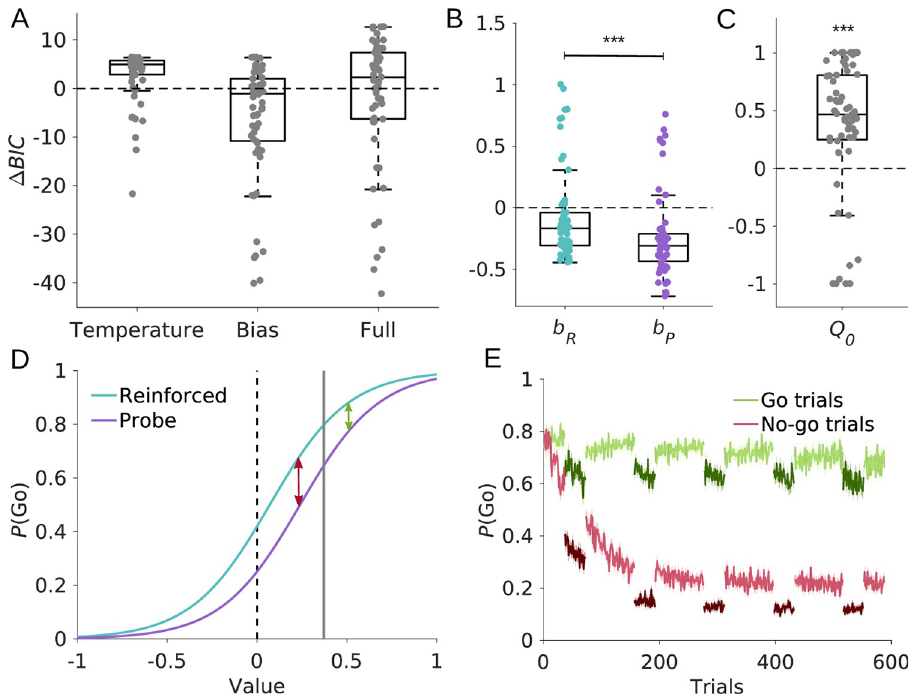
Fig 3. Computational modelling results. (A) Comparison of the Bayesian information criterion ( BIC ) relative to the baseline model. Negative BIC differences indicate a decrease in BIC relative to the baseline model and hence better fit. Conversely, a positive BIC difference indicates worse fit. The bias model provided the best fit. (B) The bias model contained two separate bias parameters, b and b , for reinforced and probe blocks, respectively. The bias is reduced R P on probe compared to reinforced trials. (C) Initial estimates Q 0 of option values. On average, estimates were initialized with positive values. (D) Softmax choice probabilities to select an option as a function of its value. The sigmoids for reinforced and probe trials were generated using the mean fitted parameters. This figure illustrates how a reduction in response bias together with a positive value initialization resulted in the increase in d’ observed in behaviour. Solid vertical grey line indicates average Q . As values of go stimuli were acquired (shifting rightwards from the vertical line), 0 the difference in action probabilities between probe and reinforced trials became smaller (green arrow). Conversely, as values of no-go stimuli were acquired (shifting leftwards from the vertical line), the difference became more pronounced (red arrow), thus leading to a stronger reduction in false alarm rates. (E) Time course of simulated go- response probabilities. The probability P (Go) for go trials (green) and no-go trials (red) was simulated based on the bias model. Darker shades of green and red indicate probe trials. Solid lines represent mean, shaded areas SEM across